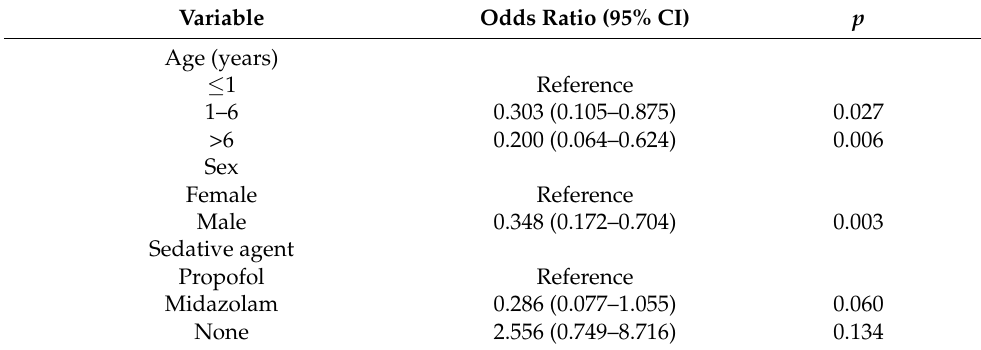
Table 5. Bivariate regression analysis for the risk of adverse